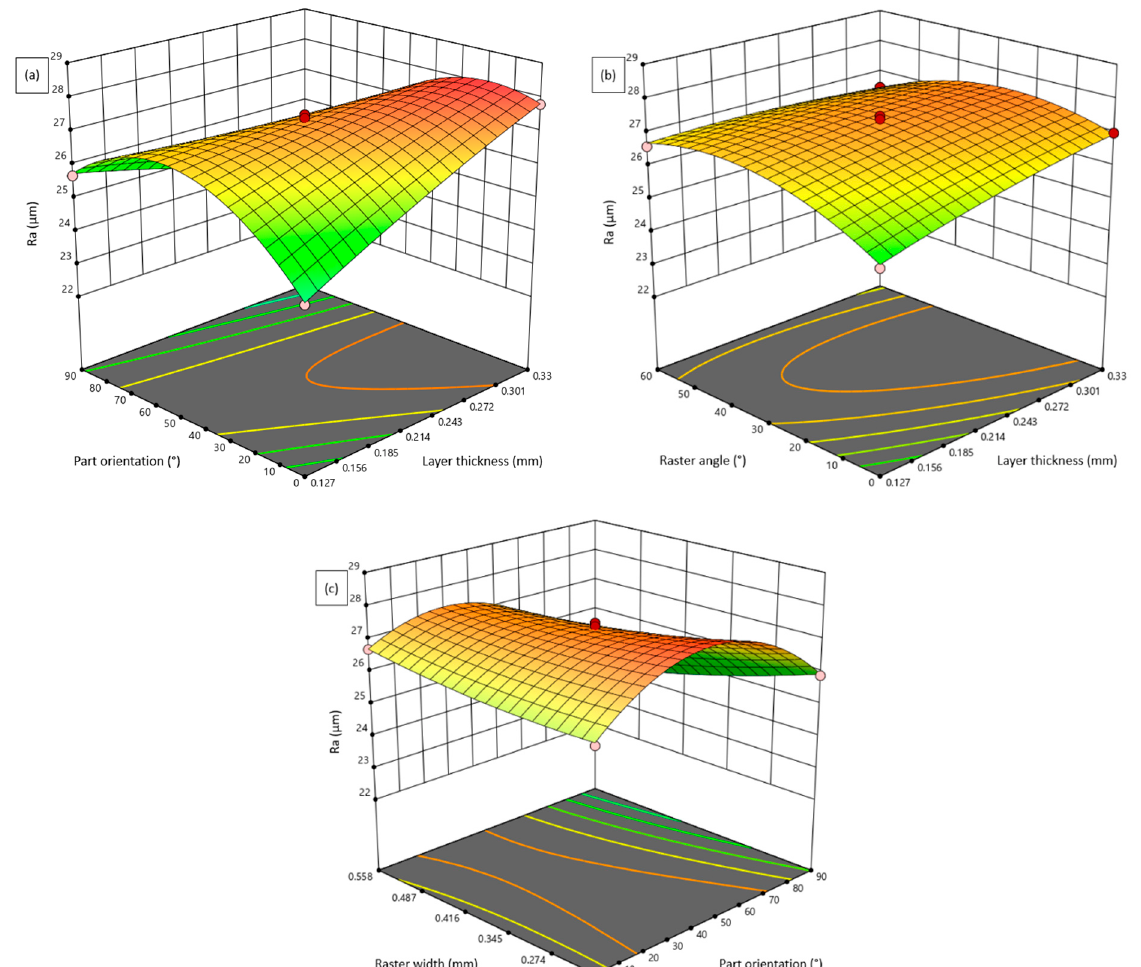
Figure 3. Influence of FDM parameters on Ra: ( a ) Layer thickness vs. Part orientation; ( b ) Layer thickness vs. Raster angle; and ( c ) Part orientation vs Raster width